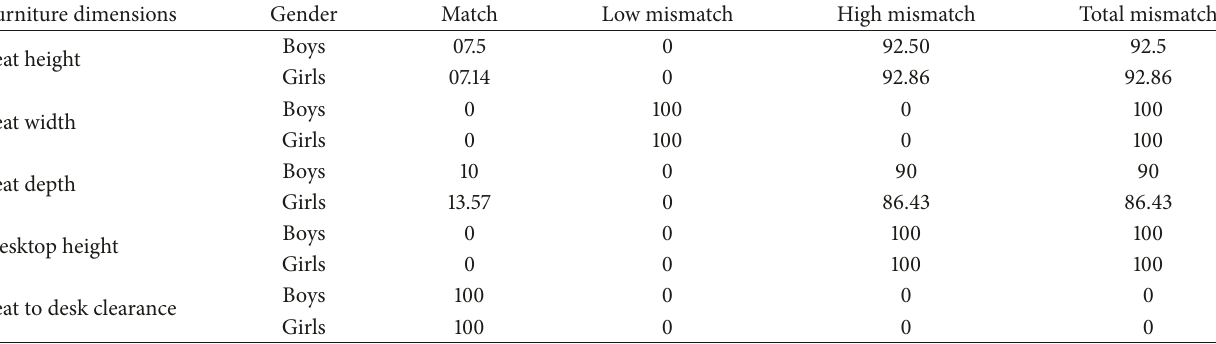
Table 4: Mismatch percentages of existing furniture.